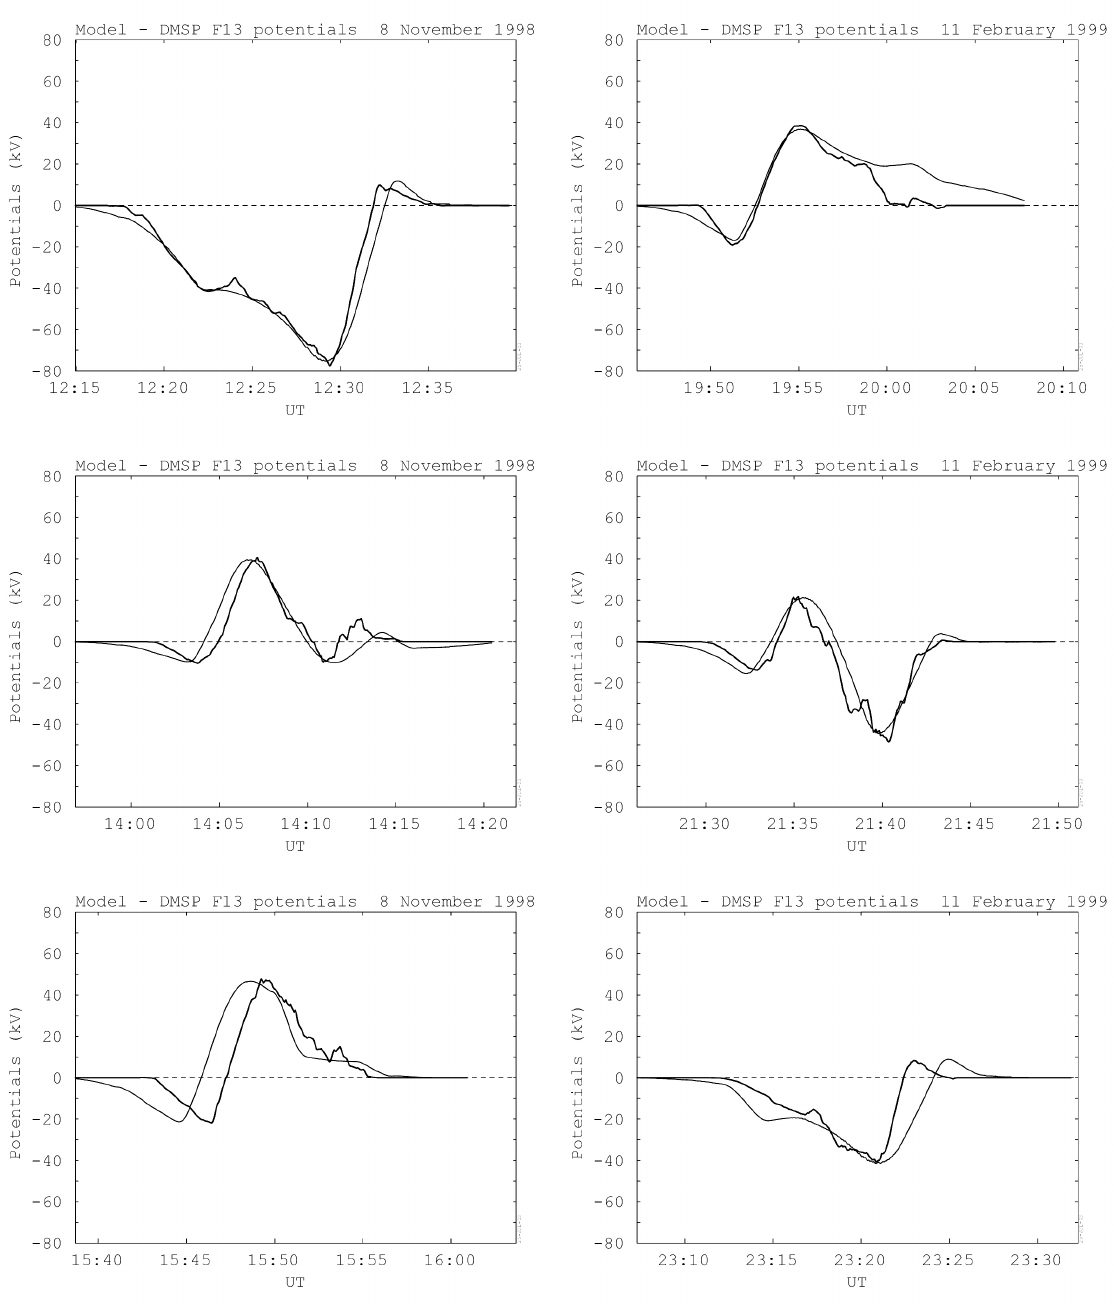
Fig. 12. Shown are the calculated electrostatic potentials of both the DMSP F13 measurements (thick line) and the model (thin, smooth line), along the F13 satellite track. Plots on the left-hand side correspond to the three F13 satellite orbits (Figs. 4 through 6) and three potential plots (Fig. 10) for 8 November 1998; plots on the right correspond to 11 February 1999 (Figs. 7 through 9 and